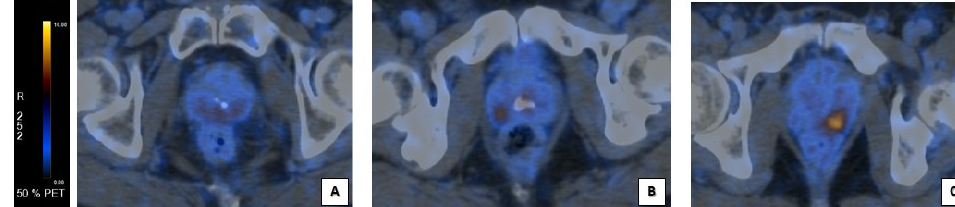
Figure 2. Corresponding visual score at PSMA-PET/CT scans’ analysis. Fusion images of the prostate gland: ( A ) faint diffuse PSMA uptake at prostate gland in VS1+ corresponding to image D in Figure 1 ( B ) focal PSMA uptake at the right lobe of prostate’s base in a VS2+ corresponding to image E in Figure 1; ( C ) focal, intense PSMA uptake at the left lobe of prostate’s base in a VS3+ corresponding to image F in Figure 1.